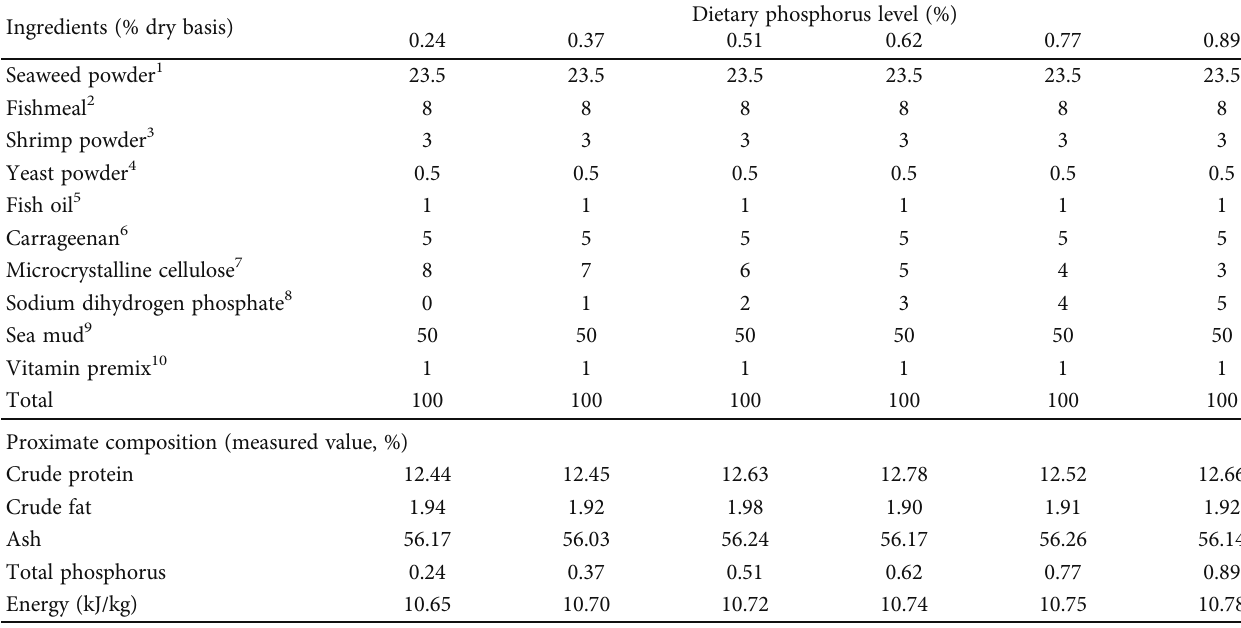
Table 1: Formulation and proximate composition of the experimental